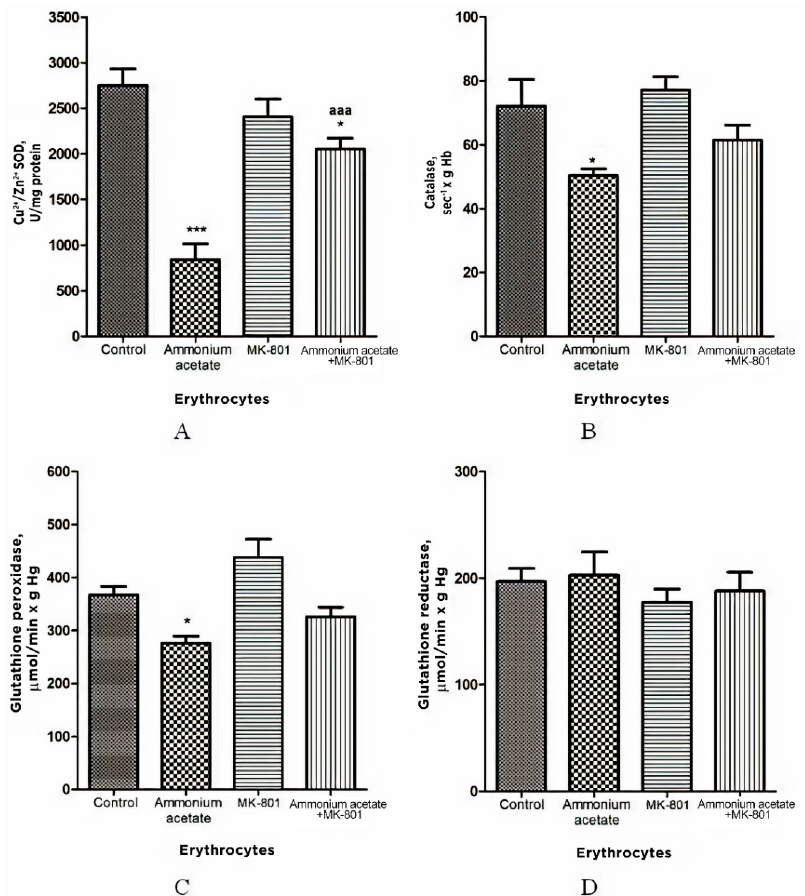
Figure 3. Activities of antioxidant enzymes superoxide dismutase ( A ), catalase ( B ), glutathione peroxidase ( C ), and glutathione reductase ( D ) in erythrocytes of animals in different experimental groups. Experimental design was the same as in Figure 1 legend. Erythrocyte enzyme activity was measured as indicated in Materials and Methods. The results are presented as mean ± SEM. Values significantly different from control are designated with one (*) and three (***) asterisks: * p < 0.05, *** p < 0.001 (Student’s t -test). a significant differences, compared with the ammonia group. aaa p < 0.001 (with the Bonferroni correction for multiple